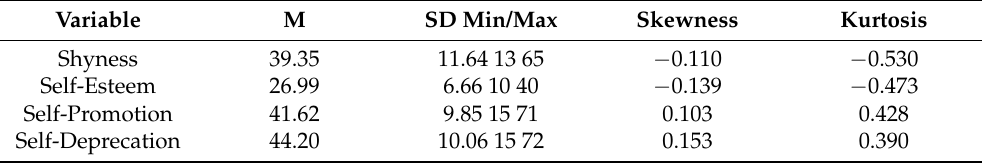
Table 1. Descriptive statistics for shyness, self-esteem, self-promotion, and self-deprecation (N = 198). Variable M SD Min/Max Skewness Kurtosis Shyness 39.35 Self-Esteem